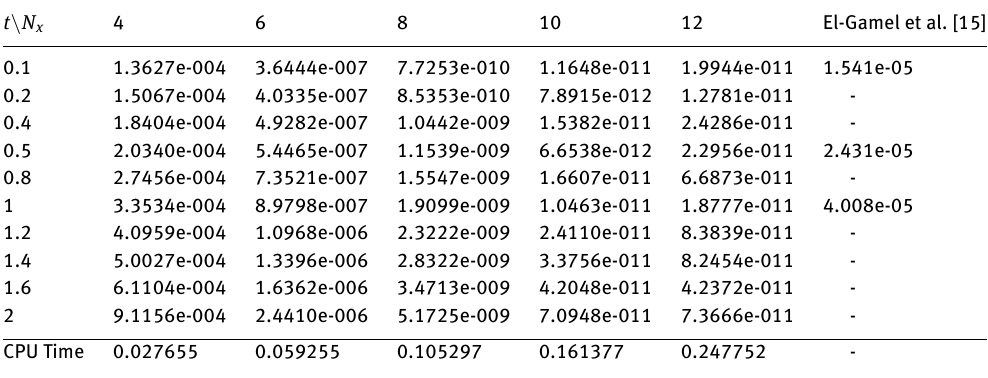
Table 2: Maximum errors E N for example 2 using N t = 10 and m = s = 3